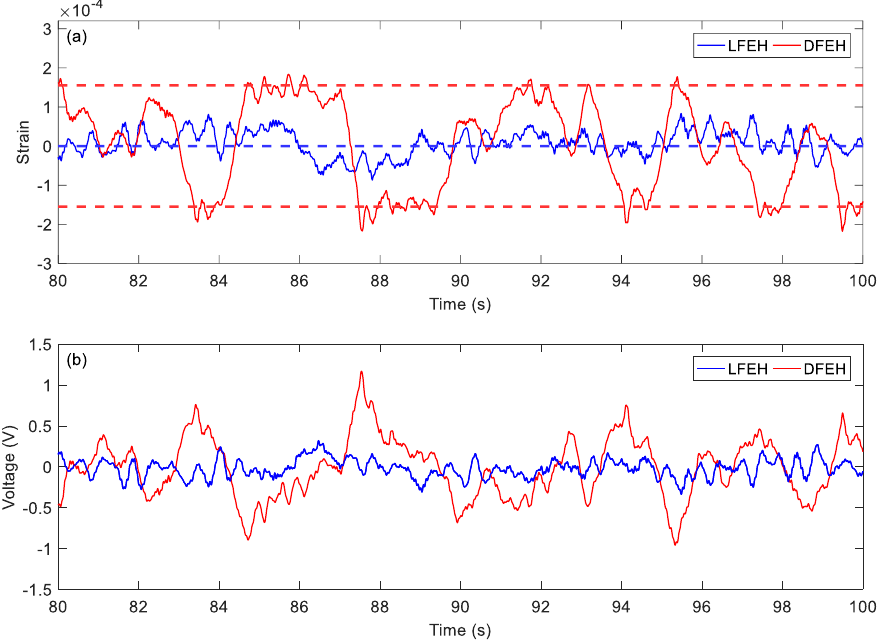
Figure 22. Tri-stable jumping ( a ) strain response and ( b ) voltage response ( 𝑣 = 4.5 m/s).